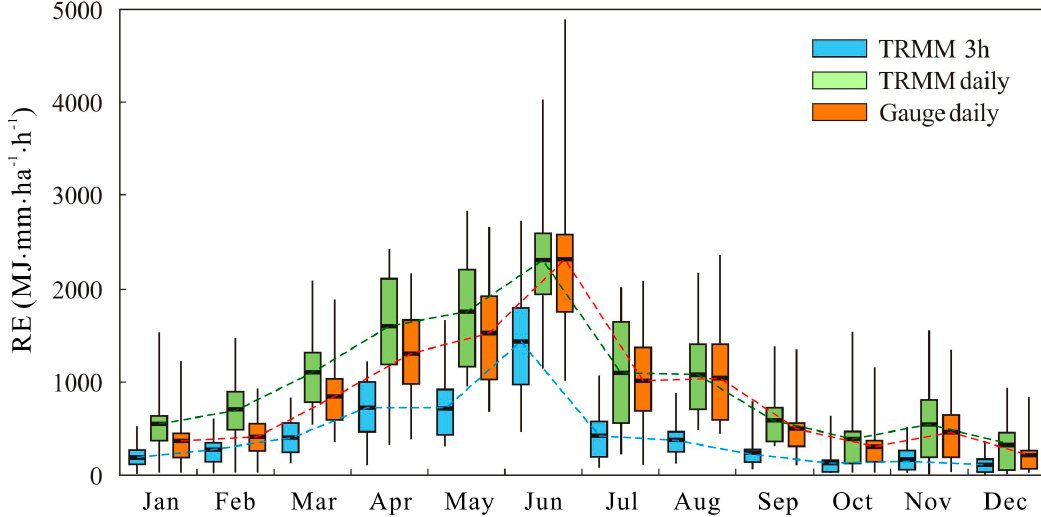
Figure 3. Comparison of monthly rainfall erosivity (RE) from different rainfall data.